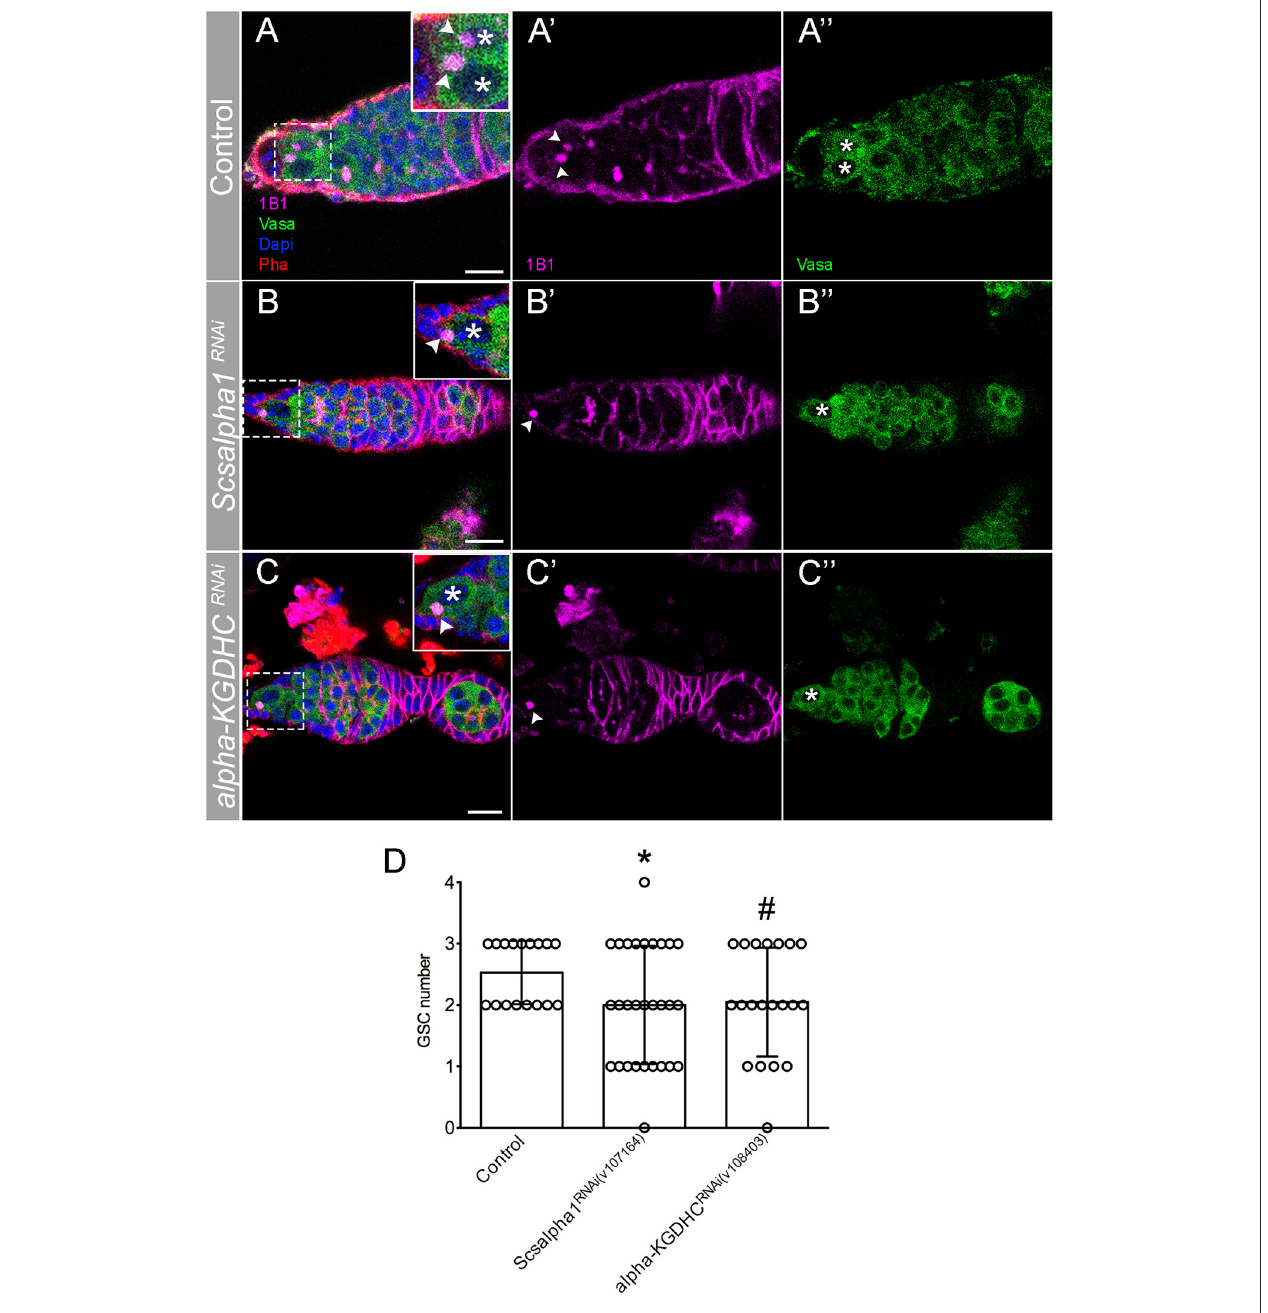
FIGURE 6 | RNAi of TCA cycle enzymes leads to GSC loss. (A–C) Representative images of adult Drosophila germaria expressing mCherry RNAi (control) (A–A ′′ ) , Scsalpha1 RNAi (B–B ′′ ) , or alpha-KGDHC RNAi (C–C ′′ ) in the germline ( nos Gal4). Scsalpha1 RNAi leads to a significant loss of GSCs. Despite not statistically significantly, alpha-KGDHC RNAi also affects GSCs number. Spherical spectrosome (1B1, pink) identifies GSCs. Germ cells are labeled by Vasa antibody (green), nuclei by DAPI (blue), and F-actin by Phalloidin (Pha, red). Scale bars represent 10 µ m. (D) Quantification of the average number of GSCs per germarium ( ± SD). Statistical significance of differences compared with control was calculated using simple sample t -test. * P < 0.05; # P <